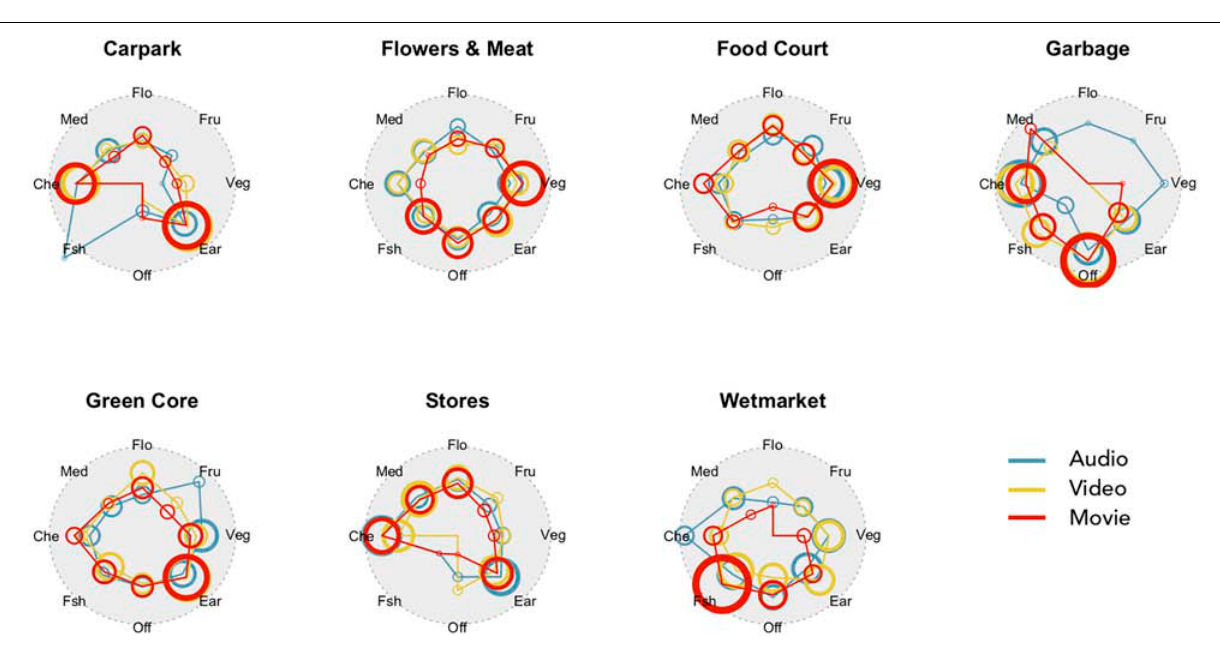
FIGURE 7 | Graphical illustration of smell types (qualities) and intensities in seven locations and in three modalities. Smell types are abbreviated for clarity: Veg, vegetable; Fru, fruity; Flo, floral; Med, medicinal; Che, chemical; Fsh, fishy; Off, offensive; Ear, earthy. Colours refer to modalities, i.e., stimuli conditions. For each smell type and modality, the coloured ring is centred on the mean distance of clicks, and its thickness and size are proportional to the number of clicks